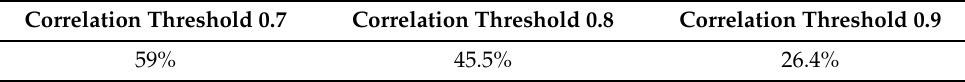
Table 4. Percentage of usable pulse waves per correlation threshold. Only pulse waves whose correlation with a reference pulse wave exceeds the threshold are considered